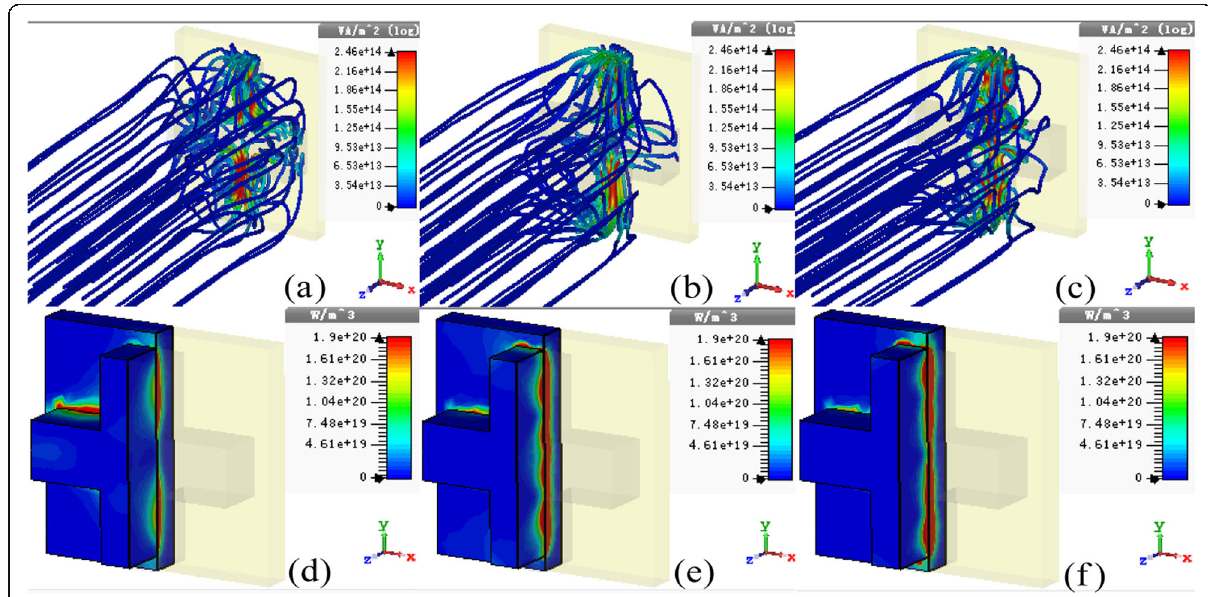
Fig. 4 The three-dimensional (3D) distributions of the a – c power flow stream and d – f power loss density of the PLA at different resonance frequencies: ( a , d ) f 1 = 402.5 THz, ( b , e ) f 2 = 429.5 THz, and ( c , f ) f 3 = 471.5